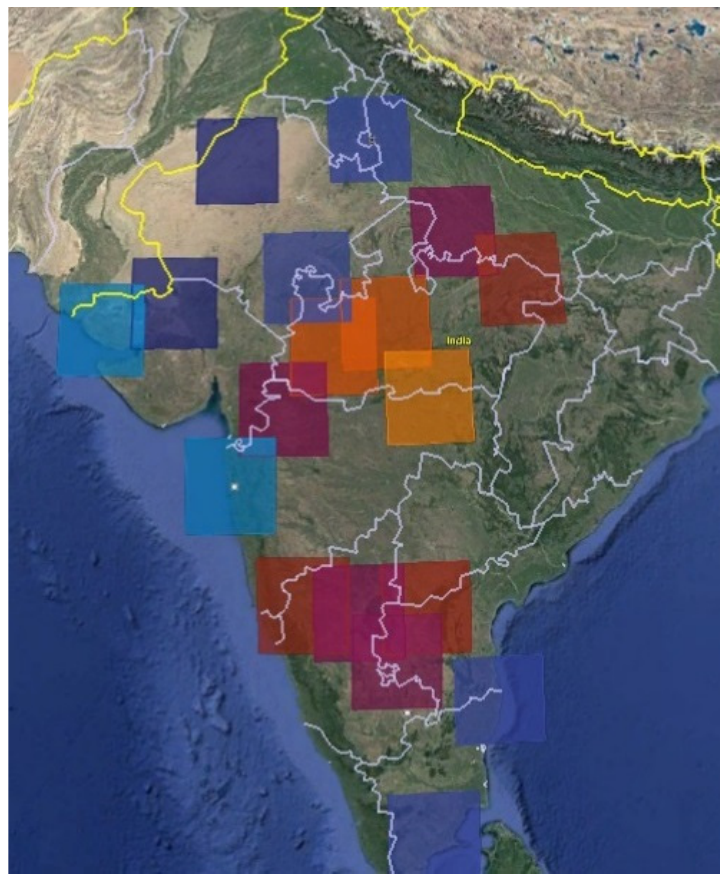
Figure 10. Cosine similarity between 0th patch and other patches on the world map from Google Earth.